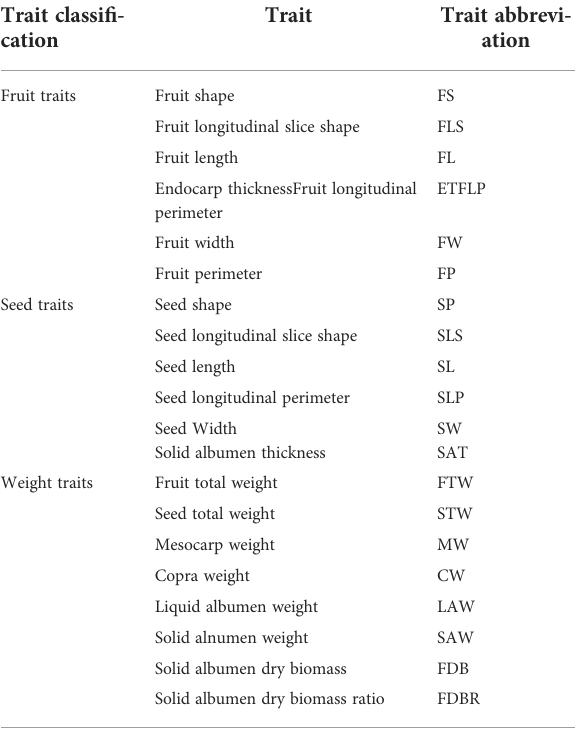
TABLE 1 The argronimic trait classi fi cation and abbreviation. Trait classi fi